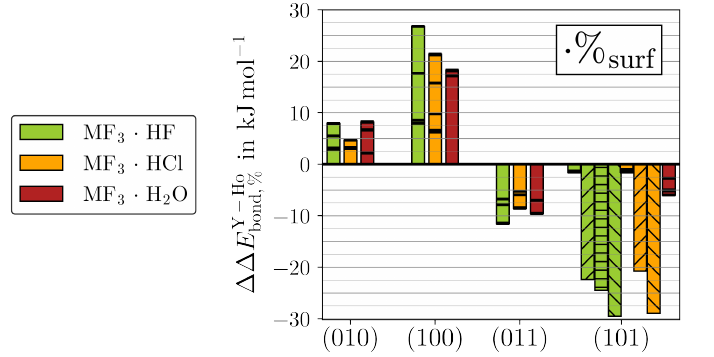
Figure 8. The % surf -weighted differences in ∆ E bond between YF 3 and HoF 3 ( ∆∆ E Y–Ho ) (see bond,% Equation (5)) is given for all adsorptions (black lines). The bar plots highlight the respective strongest adsorptions. The hydride-forming adsorptions of (101) · H F/Cl (upward stripes), (101) · H F 3Å 3.5Å (horizontal stripes), or (101) · H F/Cl (downward stripes) are given 7Å